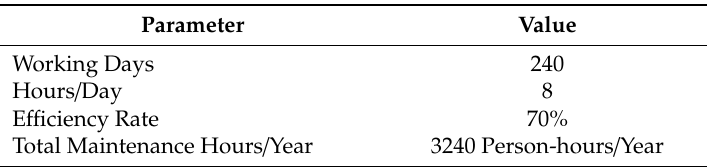
Table 3. Operational parameters.